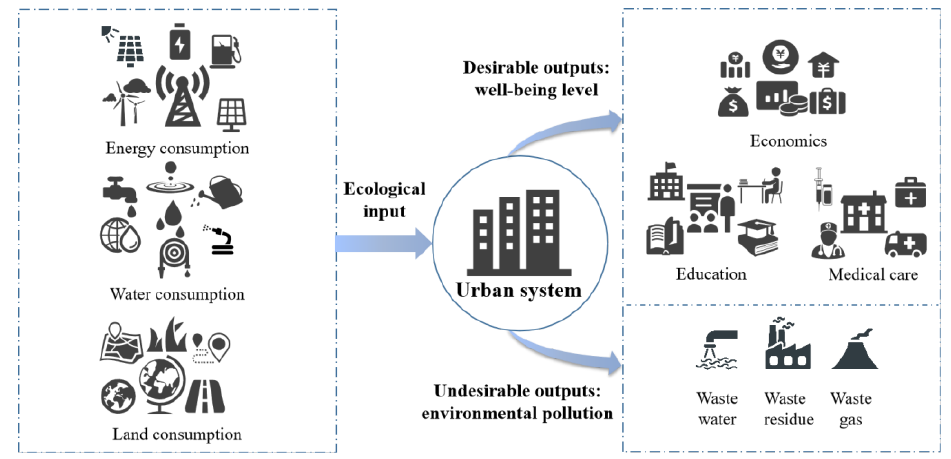
Figure 3. The evaluation indicator structure of the EWP.